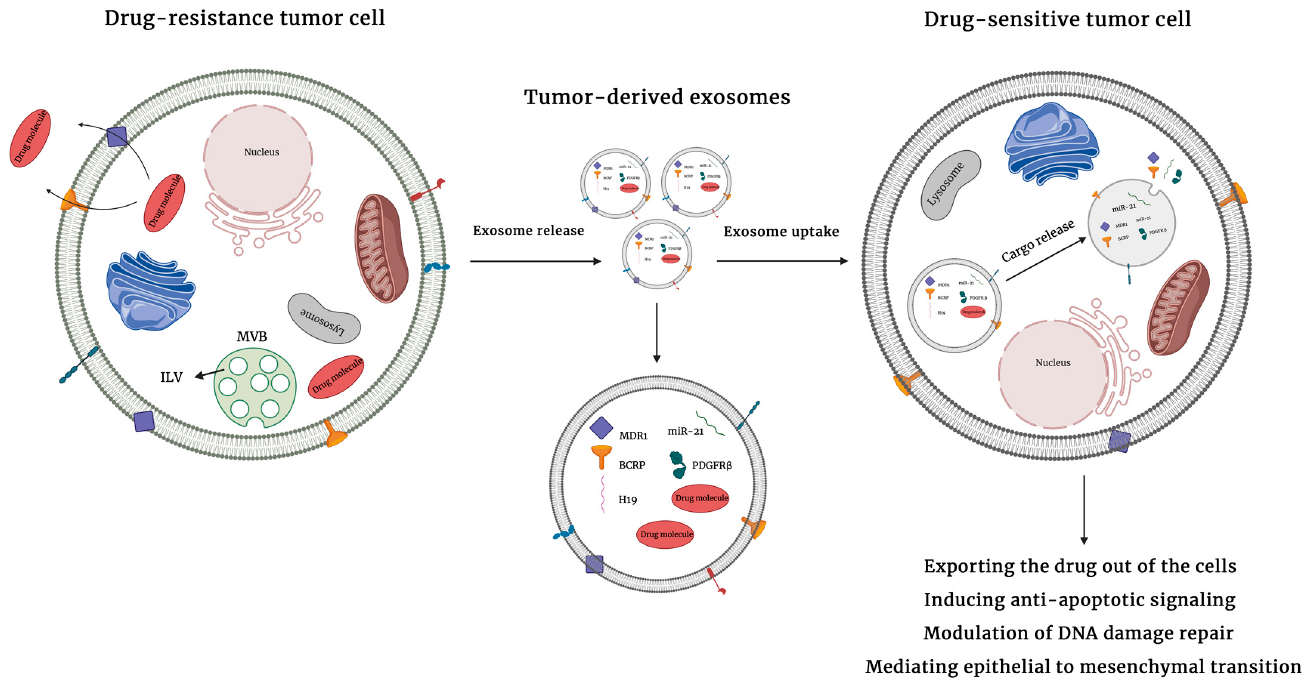
Figure 1. Mechanisms of extracellular vesicles-mediated drug resistance. Extracellular vesicles can induce drug resistance by directly transferring bioactive cargo molecules including drug efflux pumps, inhibitors of apoptosis, and prosurvival molecules to neighboring cells as well as cells in the tumor microenviroments. The uptake of cargo by recipient cells promotes drug resistance by exporting drugs out of cancer cells, inducing anti-apoptotic signals, modulating DNA damage repair, or mediating epithelial to mesenchymal transition.